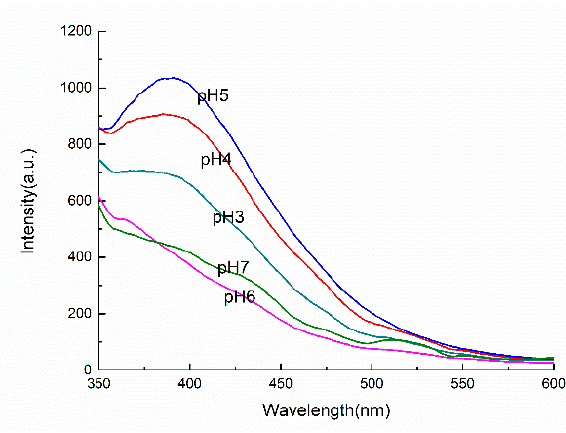
Figure 11. Effect of pH on fluorescence intensity of LOPC.